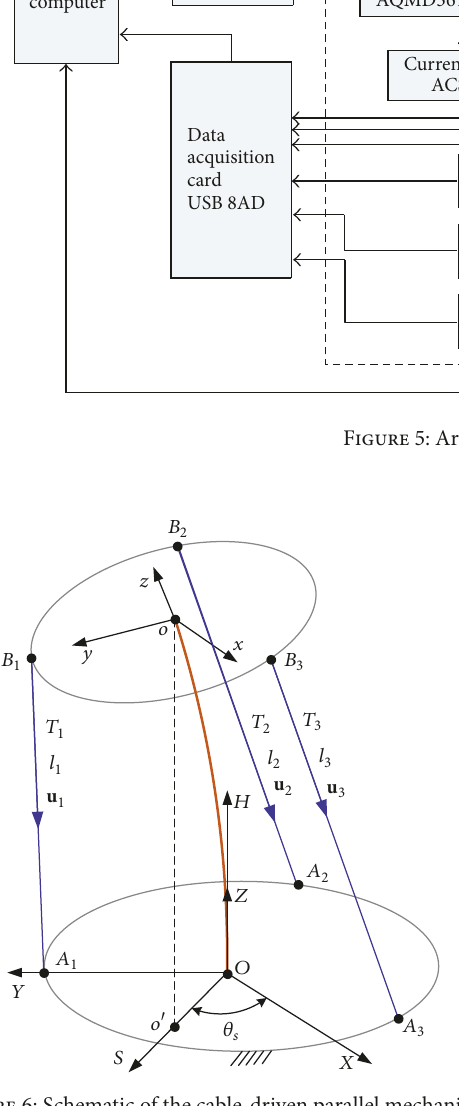
Figure 6: Schematic of the cable-driven parallel